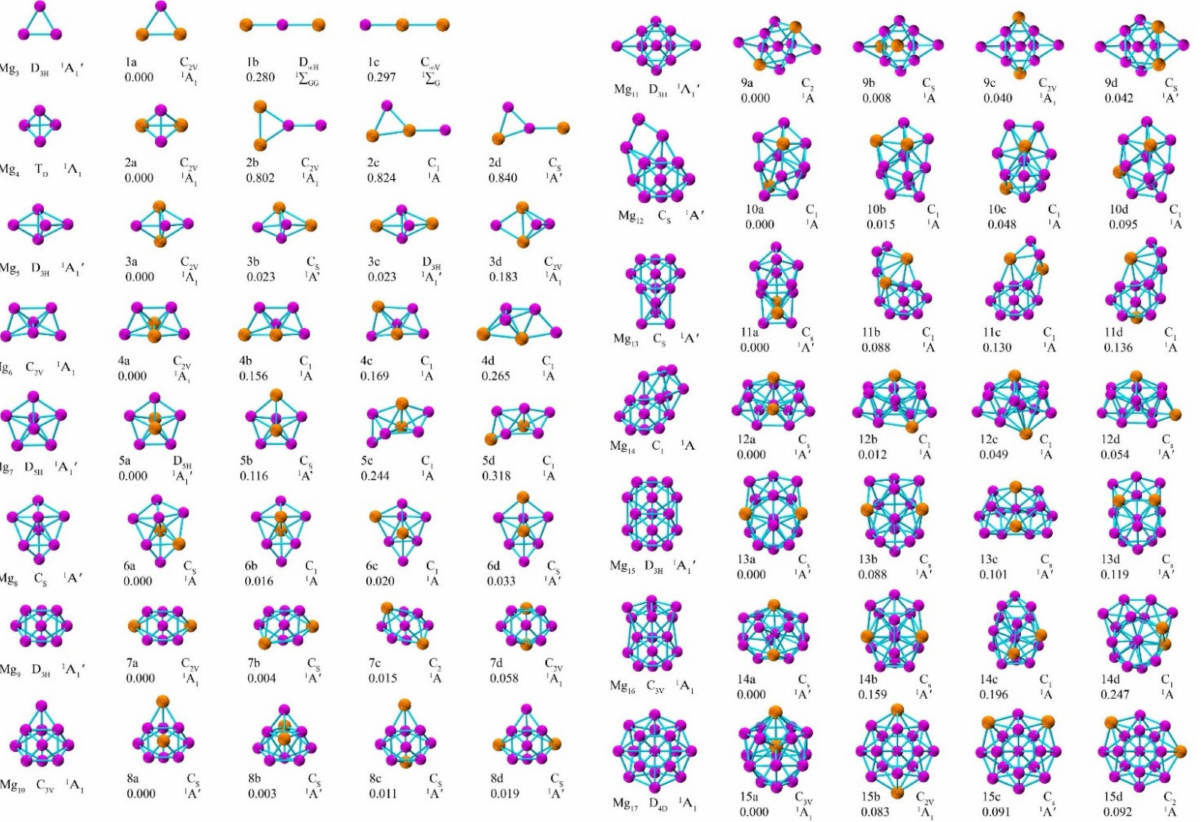
Figure 1. Optimized geometrical structures of lowest and low-lying isomers of Ca 2 Mg n ( n = 1–15) clusters and Mg n +2 ( n = 1–15) clusters along with the point group symmetry, electronic states and relative energy (eV). The pinkish and orange balls are magnesium and calcium atoms,